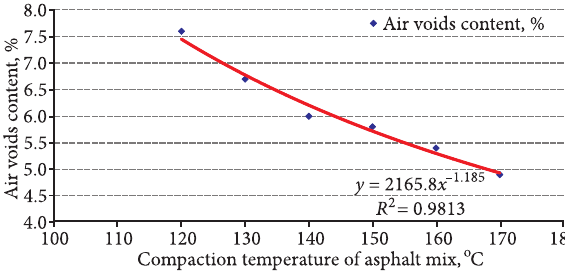
Fig. 7. Dependence of temperature compaction and air voids content in asphalt